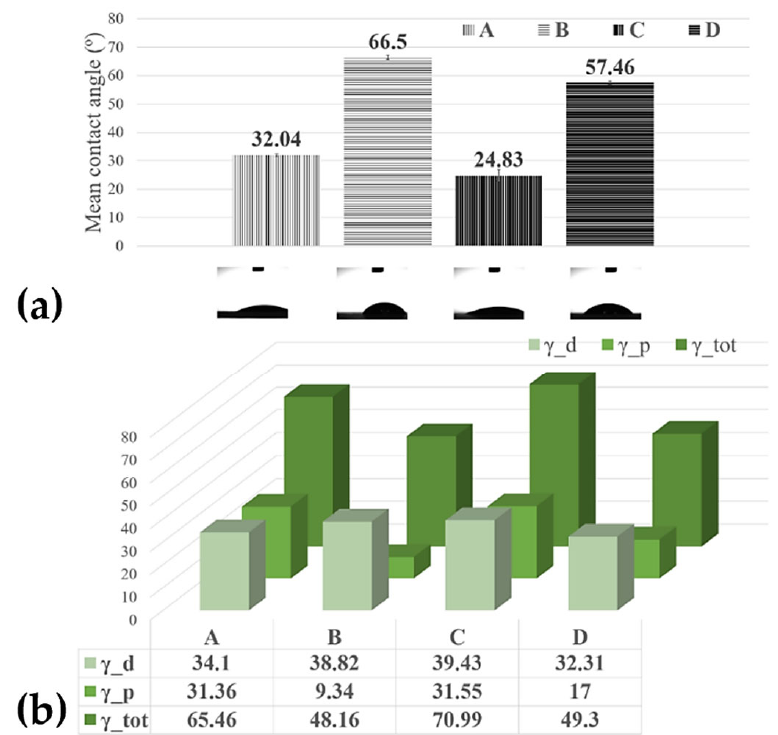
Figure 3. ( a ) Histograms of the contact angles measured on the MAPLE processed surfaces; ( b ) surface free energy of the MAPLE processed surfaces from targets with the different compositions: Sample A (target containing (15% CNT + 1% Chit + 1% C 32 H 16 FeN 8 ) in H 2 O); Sample B (target containing (15% CNT + 1% Chit + 0.4% C 32 H 16 FeN 8 ) in H 2 O); Sample C (target containing (22% CNT + 1% Chit + 0.4% C 32 H 16 FeN 8 ) in H 2 O); Sample D (target containing (22% CNT + 1% Chit + 1% C 32 H 16 FeN 8 ) in H 2 O).